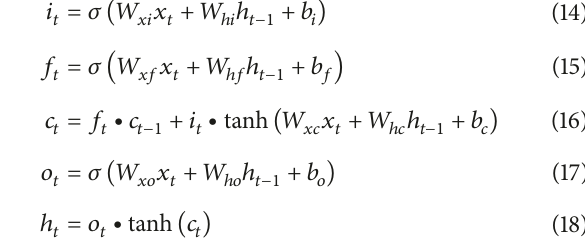
vector at time step 𝑡 , respectively, and 𝑏 𝑠 and 𝑏 𝑜 correspond to the biases of hidden layer and output layer, respectively.